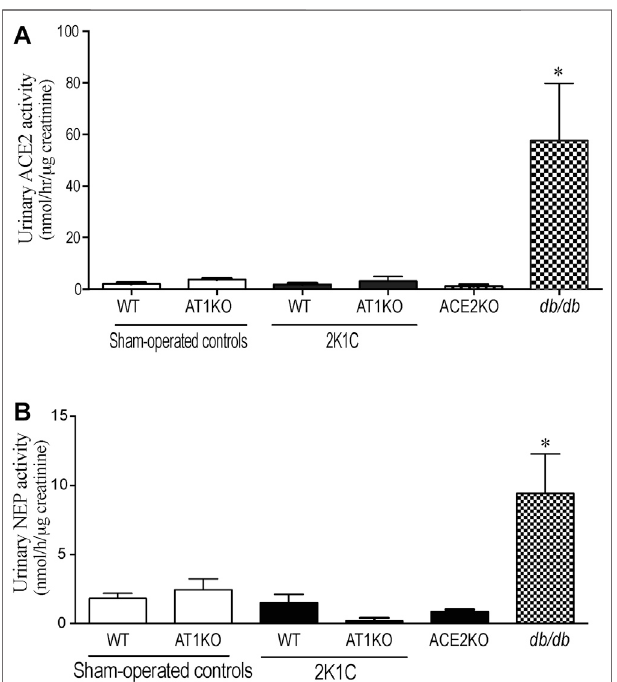
FIGURE 9 | Effect of renovascular hypertension on urinary ACE2 and NEP activity in WT and AT1KO mice after 2 weeks of 2K1C Goldblatt surgery. (A) urinary ACE2 activity in WT (sham), WT (2K1C), AT1KO (sham), AT1KO (2K1C) was measured using 6 – 10 µl urine samples. Urine samples from db / db diabetic mice were used as positive control. The experiment was validated using urine samples from ACE2KO mice and ACE2 inhibitor MLN- 4670. (B) urinary NEP activity was measured in WT (sham), WT (2K1C), AT1KO (sham), AT1KO (2K1C) using 6 – 10 µl urine samples. Urine samples from db / db diabetic mice were used as positive control. The experiment was validated using kidney samples from NEPKO mice and the NEP inhibitor Thiorphan.* p < 0.0001vs.buffer.Eachbar representsmean ± SEM(n (cid:2) 6 – 8).